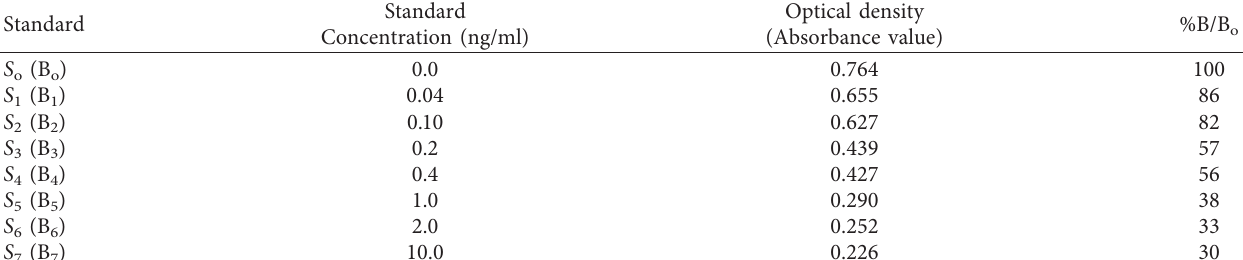
Table 1: Standard concentration (ng/ml), optical density (absorbance value), and %B/B